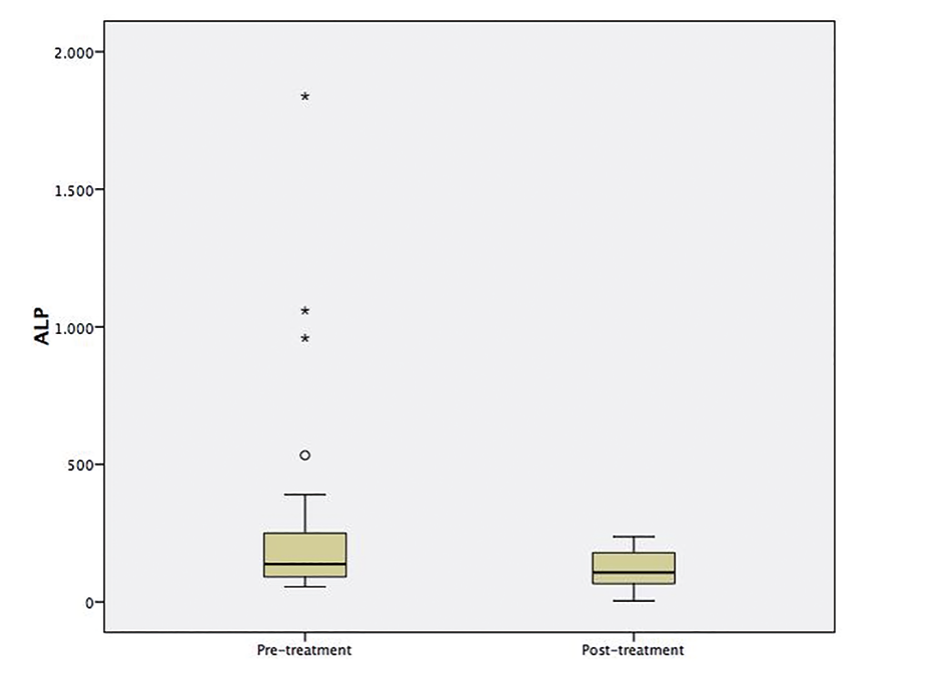
Figure 2 - Comparison ALP measurements before and after therapy with 223